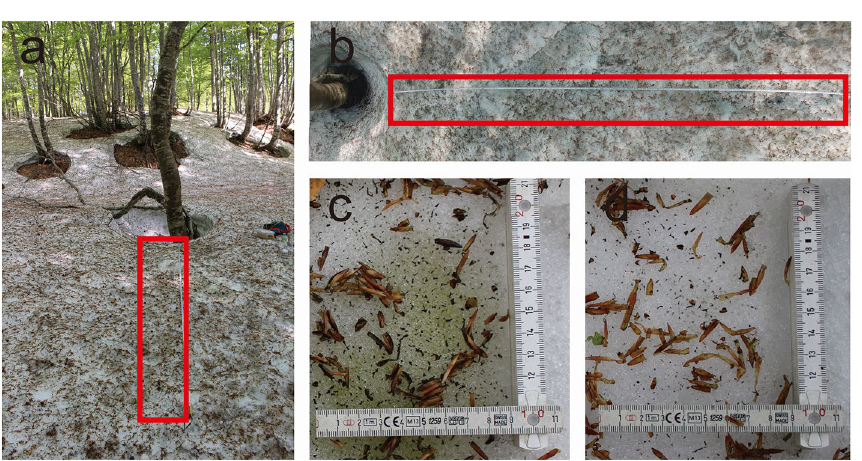
Figure 3. Snow surface collected in 2019. ( a , b ) Collection area along a lateral line (surrounded by red frame), ( c ) green snow, ( d ) white